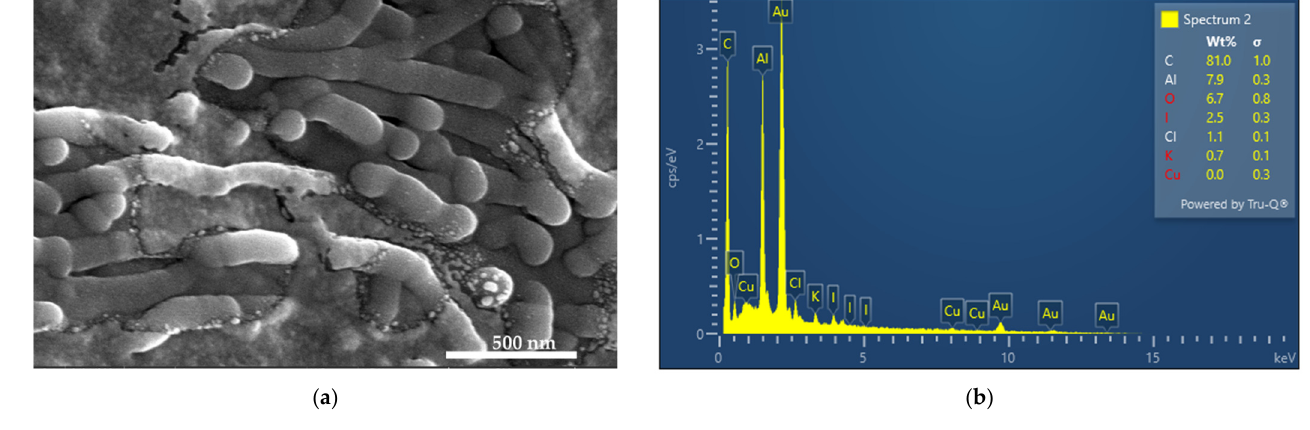
Figure 1. SEM ( a ) and EDS ( b ) of AV-PVP-TCA-I 2 .